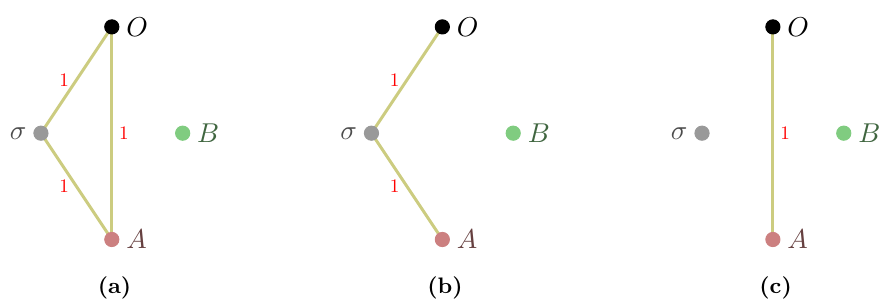
Figure 2. An example illustrating lemma 8 and the reduction described in section 3.4 for vanishing weights. The graph (a) is our starting point. The graphs in (b) and (c) are obtained by deleting from (a) the edges that correspond to the vanishing entries of the extreme rays of the closure of the W-cell specified by (a), cf. eq.